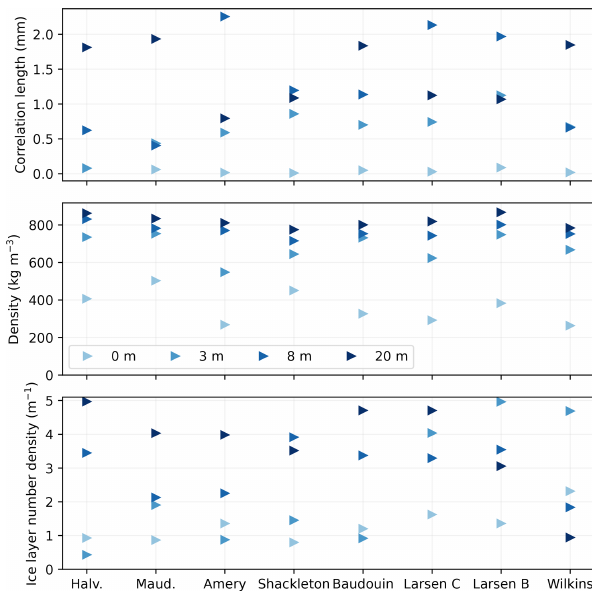
Figure 4. Grain size (i.e., correlation length), density and ice layer number density (i.e., number of layers per meter) at depths 0, 3, 8 and 20m for each site in winter. Each triangle is the average over the 1000 best parameter sets. Note that for Halvfarryggen grain size, the two triangles for 0 and 3m depth overlap, and the same applies at 3 and 8m in